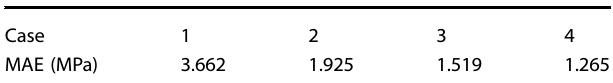
Table 2. MAE for test datasets based on the material property distributions in Eq.